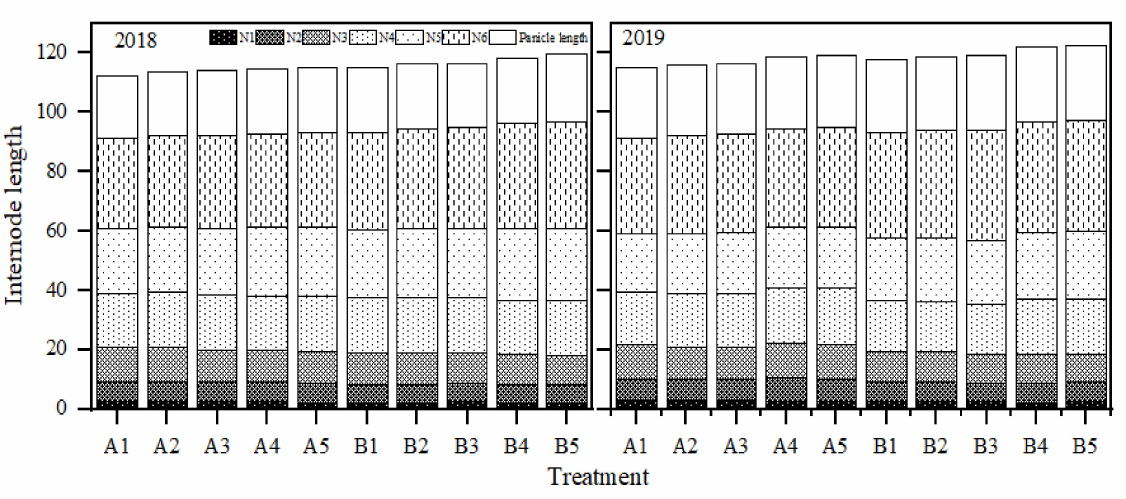
Figure 3. Rice internode configuration as affected by mechanical transplanting method and planting